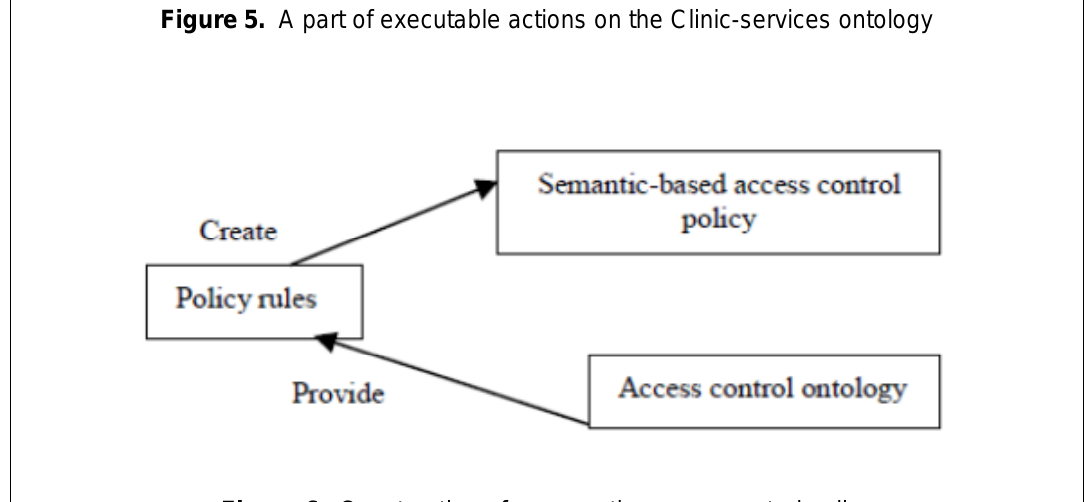
Figure 6. Construction of a semantic access control